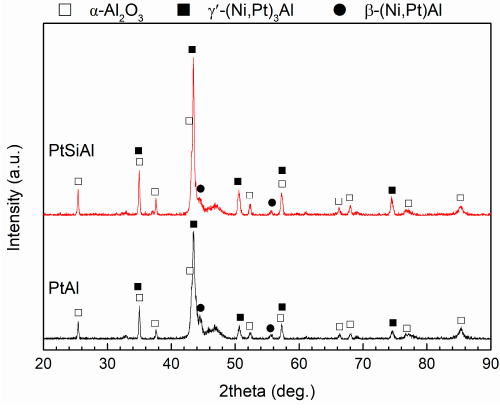
Figure 5. XRD patterns of the PtAl and PtSiAl coatings after isothermal oxidation at 1100 °C for 320 h.